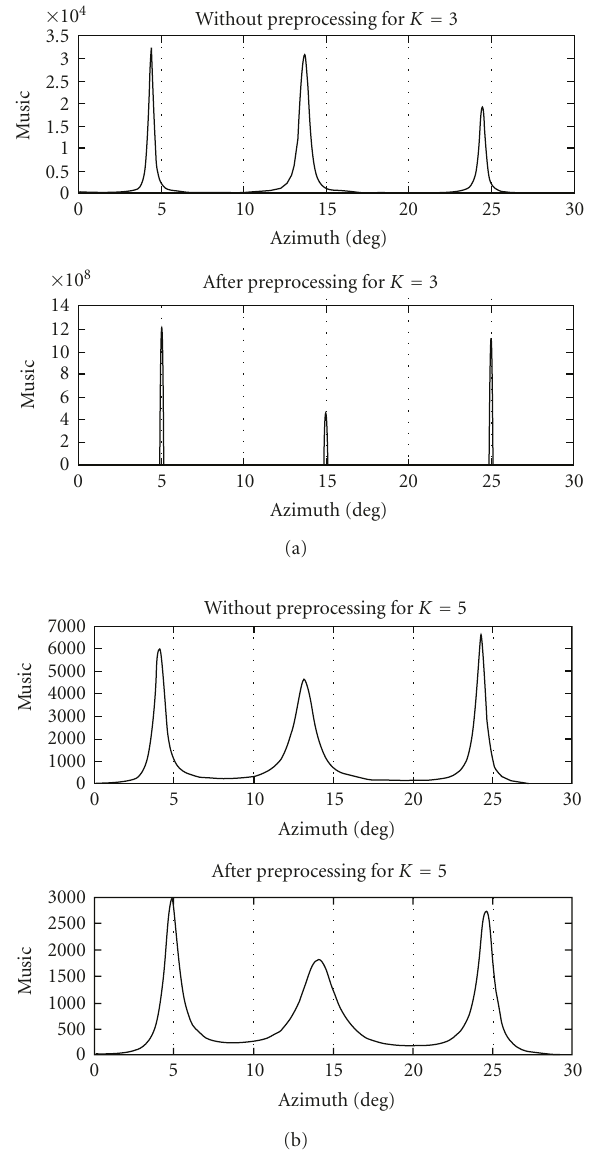
Figure 13: Bias of the direction estimate according to spatial correlation length of the